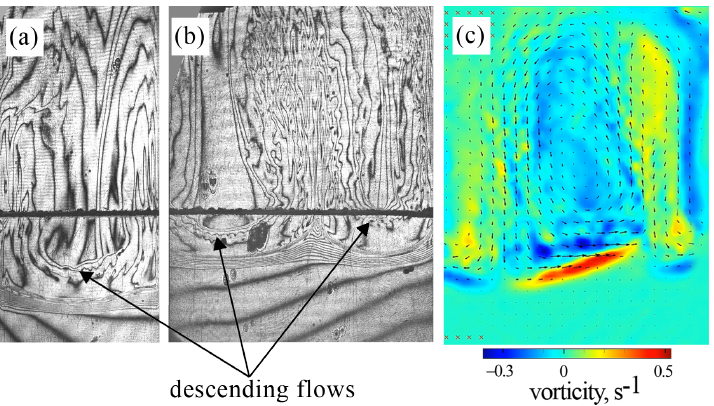
Figure 7. Comparison of the convective structure developing at α = 70 ◦ in an inclined slot with single ( a ) and doubled ( b , c ) widths. The hybrid plot in ( c ) presents the vorticity (indicated by the color map) and the time-average velocity (indicated by the vector field). Time after the experiment onset: ( a ) 240 s; ( b , c ) 100